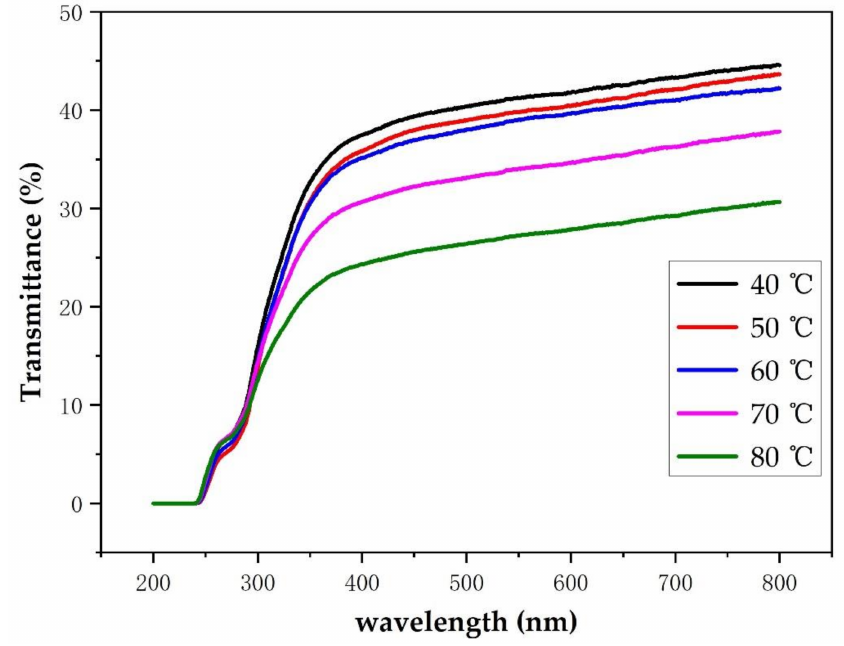
Figure 17. UV transmittance spectrum and photos of SPU films with different film forming